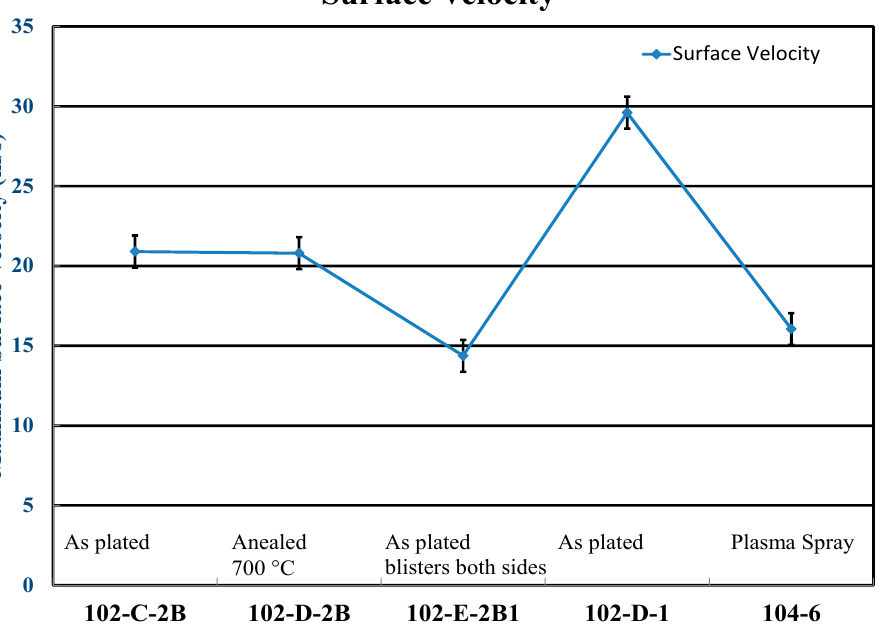
Figure 10. This graph shows the measured maximum surface velocity measured in the various Pacific Northwest National Laboratory (PNNL) interface samples with variable process parameters. The fuel plates contain the corresponding fuel foils: 21C-2B, 21D-2B, 21E-2B1, 21D-1.